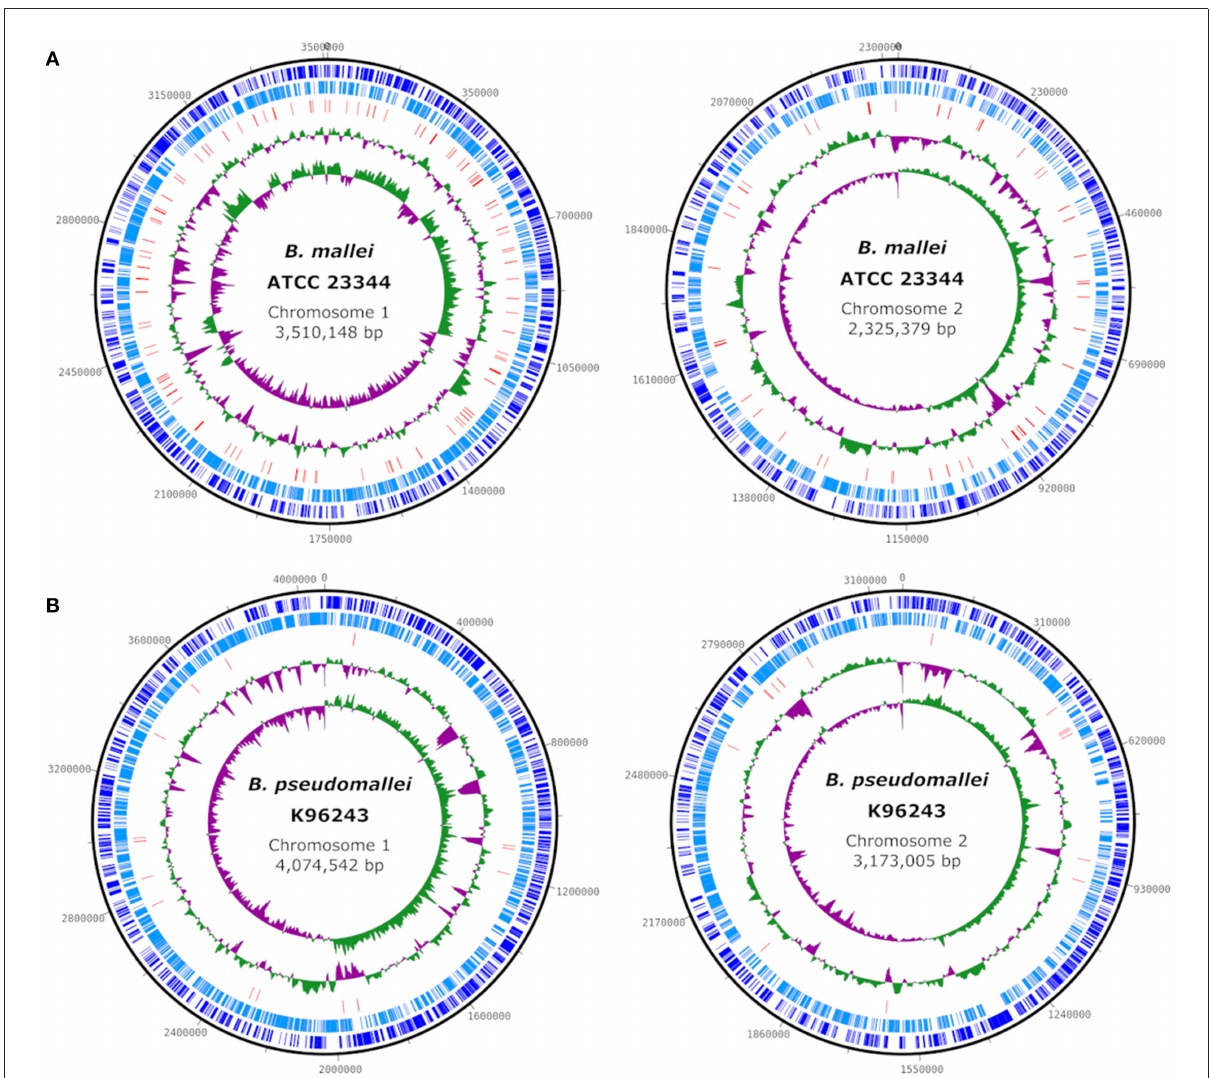
FIGURE1 Comparison of the genome structure of the type strains B. mallei ATCC 23344 (CP000010, CP000011) (A) and B. pseudomallei K96243 (NC_006350, NC_006351) (B) . Circles (from outside to inside) show the location of coding sequences on forward (dark blue) and reverse (light blue) strands, predicted transposase-coding genes (red), GC content and GC skew. Plots were created using DNAPlotter v1.11